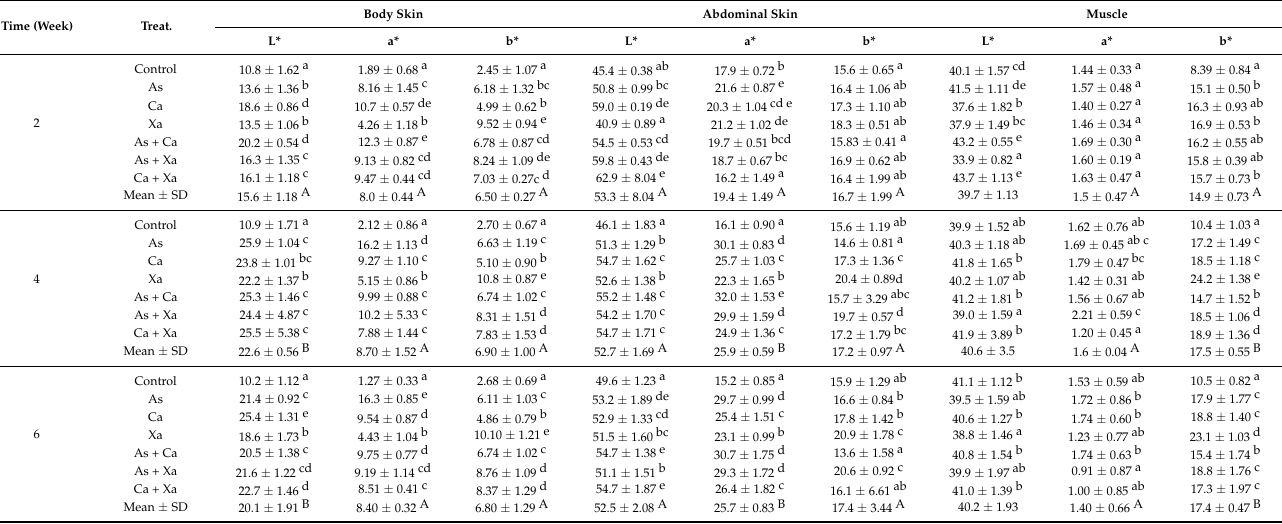
Values are mean ± standard deviation (SD) of triplicates ( n = 3); a,b,c,d,e,A,B are statistical symbols. a,b Mean values with difference superscripts in the same column within sampling time (week) are significantly different ( p < 0.05); A,B Mean values with difference superscripts in the same column are significantly different ( p < 0.05) in color performance of animal between sampling time (week) by two-way ANOVA. Abbreviation: As, Astaxanthin; Ca, Canthaxanthin; Xa, Xanthophyll.